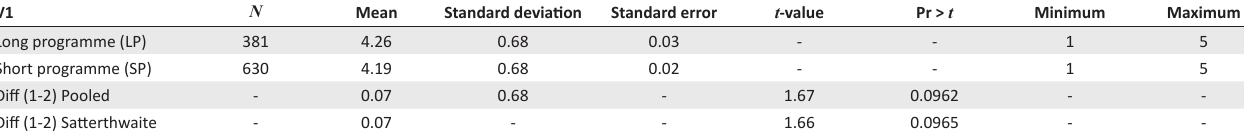
TABLE 13: Descriptive statistics of increase in predictions of entrepreneurial activity by programme duration. V1 N Mean Standard deviation Standard error t -value Pr ˃